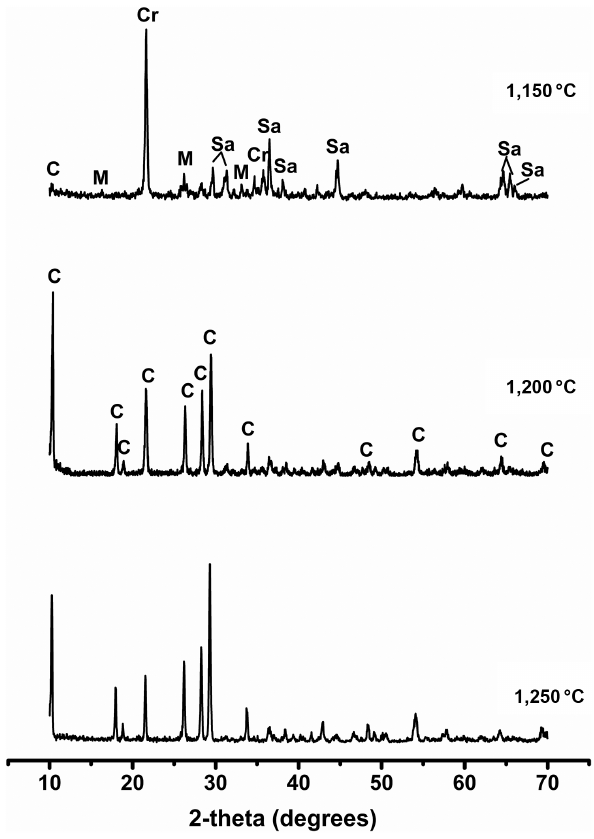
Figure 3: XRD patterns of the green compacts after sintering between 1,150°C and 1,250°C for 2